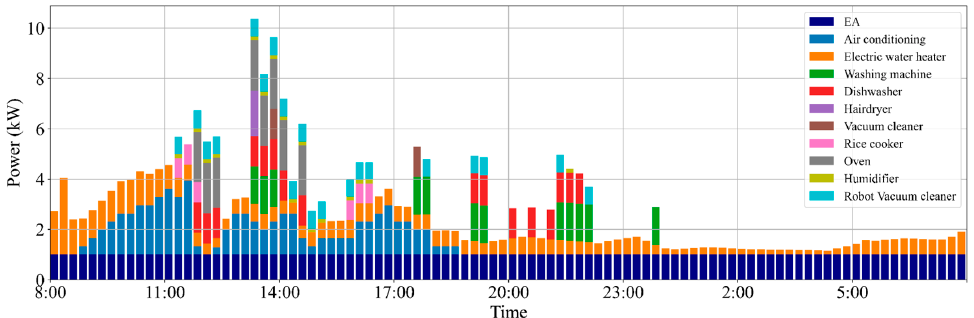
Figure 9. Overall scheduling results of all the home appliances.